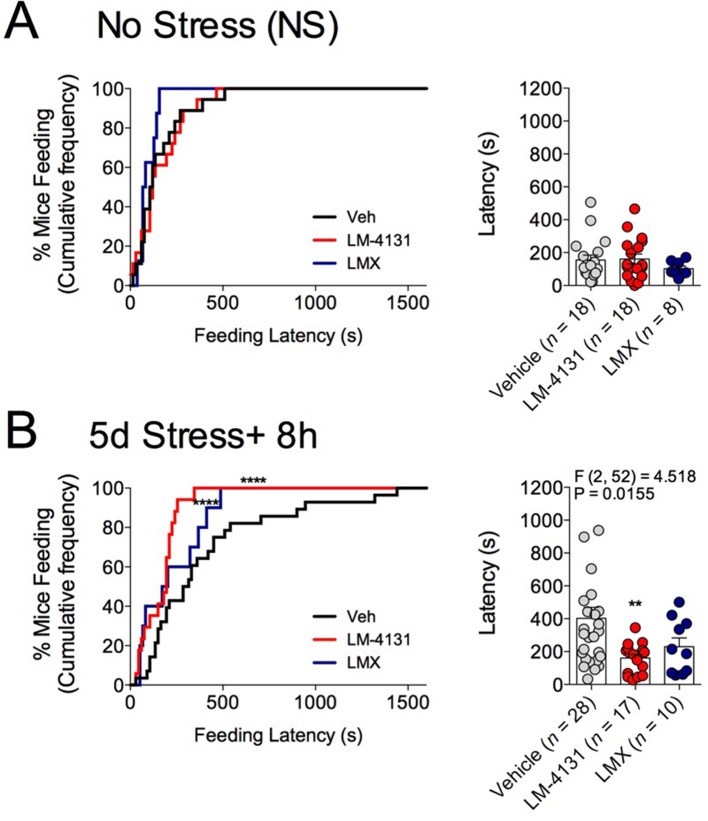
Effects of COX-2 inhibition on feeding latency in the NIH test after sub-chronic stress.(A) Effects of LM-4131 and Lumiracoxib (LMX) on feeding latency in the NIH assay under control, non-stressed conditions. (B) Effects of LM-4131 and LMX on feeding latency in the NIH assay 8 hr after the last of 5 daily foot-shock exposures. Significant F and P values by one-way ANOVA shown above figures. **p<0.01 by Holm-Sidak post hoc multiple comparisons test. For cumulative distribution curves, ****p<0.0001 by K-S test.